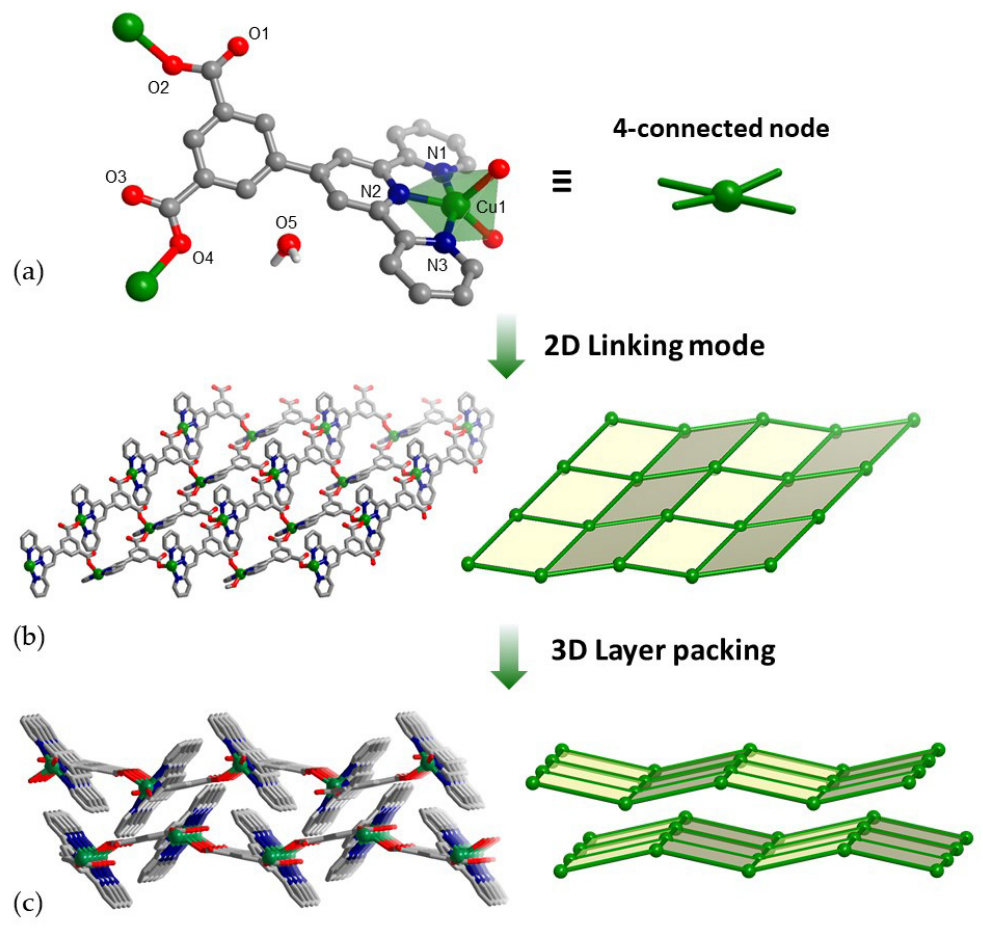
Figure 2. Asymmetric unit of 1 ( a ); the 2D “wave-shaped” layer structure as well as the linking mode of the nodes in 1 ( b ) and the 3D stacking mode of the layers in 1 ( c ) (some H atoms are omitted for clarity).